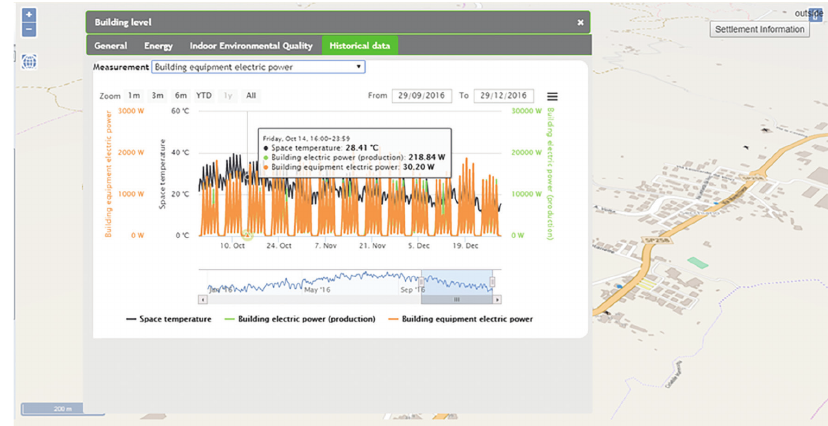
Figure 6. The ZERO-PLUS monitoring platform. Source: